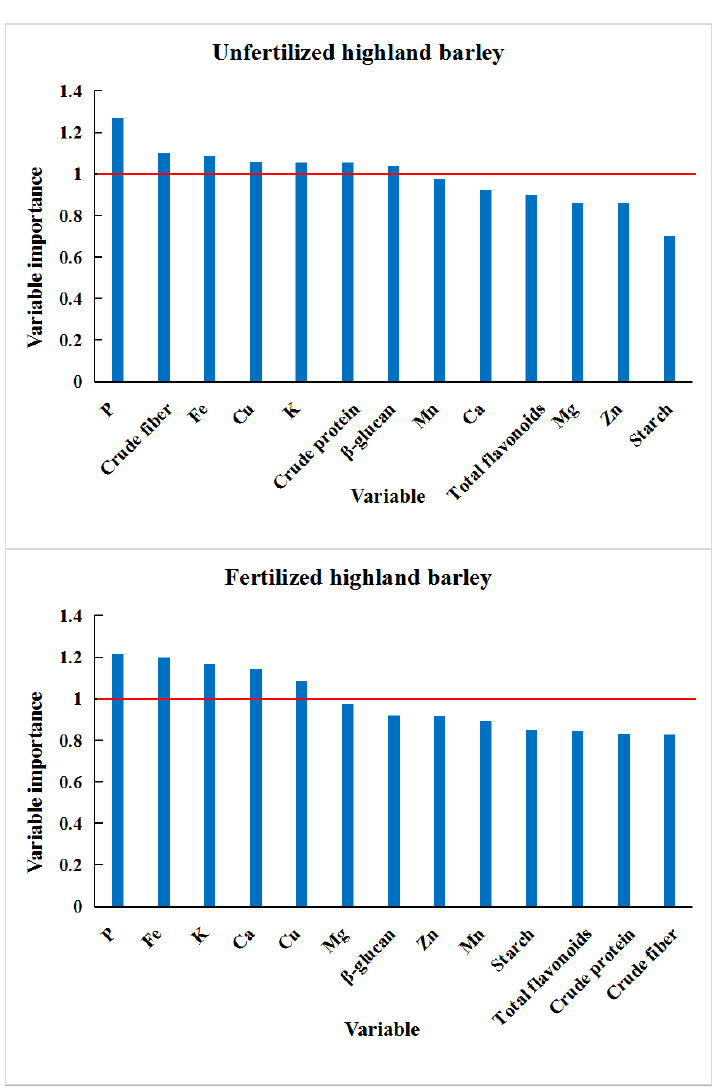
Figure 2. Variable importance projection of fertilized and unfertilized highland barley samples from five regions of Tibet with data on nutrients and mineral elements.